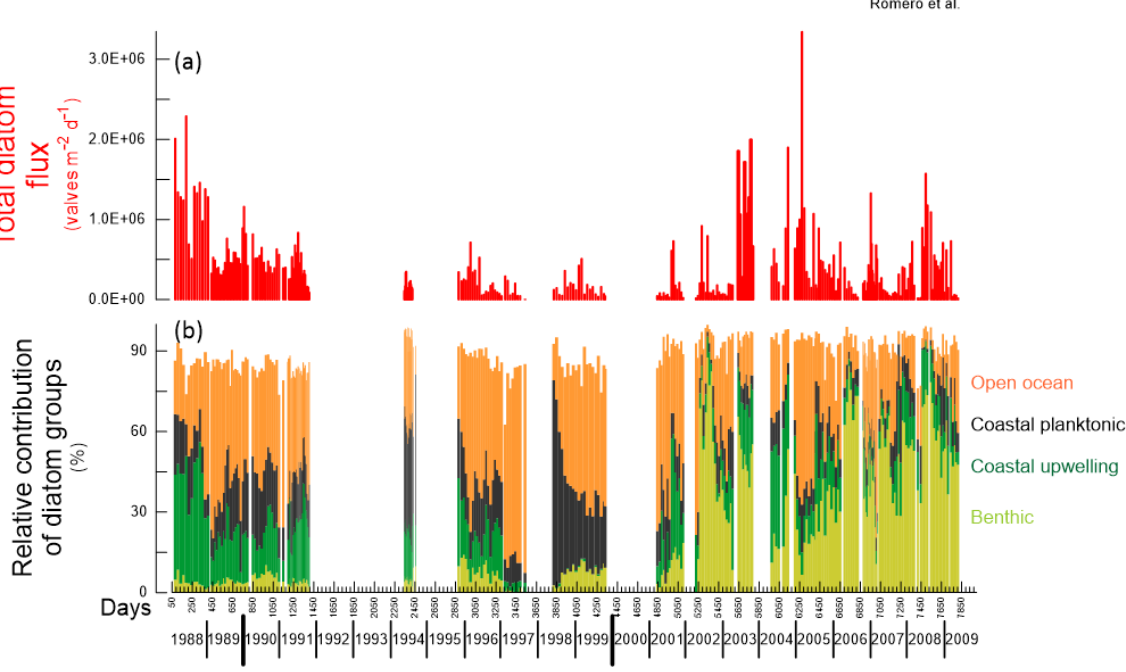
Figure 2. Total diatom flux (valves per square meter per day) and relative contribution of diatom groups (relative contribution, %) for the interval from March 1998 to June 2009 at the CBmeso site. Groups of diatoms are benthic (light green), coastal planktonic (black), coastal upwelling (dark green), and open ocean (orange). For the species-specific composition of each group, see Sect. 4.2. and Table 2. For interpretation of the references to color in this figure legend, the reader is referred to the web version of this